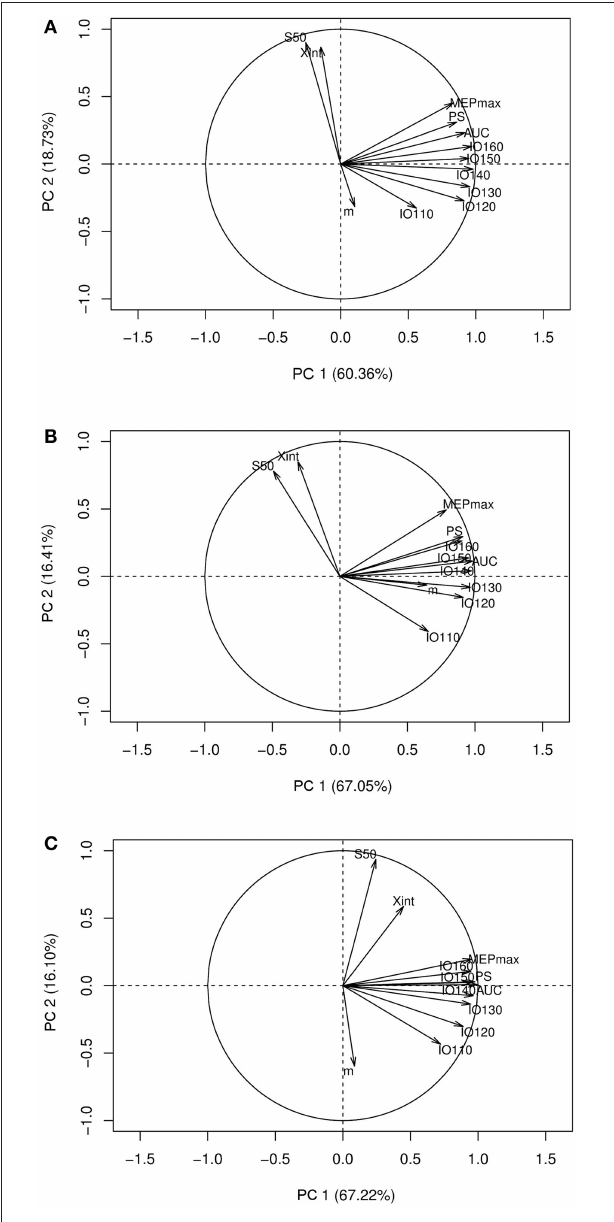
FIGURE 3 | Correlation circles with the I/O curve parameters and the MEP amplitude at stimulation intensities ranging from 110 to 160% rMT. (A) PCA graph in healthy subjects, (B) PCA graph in stroke patients in the unaffected hemisphere, (C) PCA graph in stroke patients in the affected hemisphere. PCA, principal component analysis; X int , X intercept, IO110, IO120, IO130, IO140, IO150, IO160: Motor Evoked Potentials amplitude recorded at 110, 120, 130, 140, 150, and 160% rMT, respectively; MEP max , maximum value of the sigmoid function; PS, peak slope; AUC, area under the input output curve; m, slope; S 50 , stimulus intensity needed to obtain 50% of the maximum